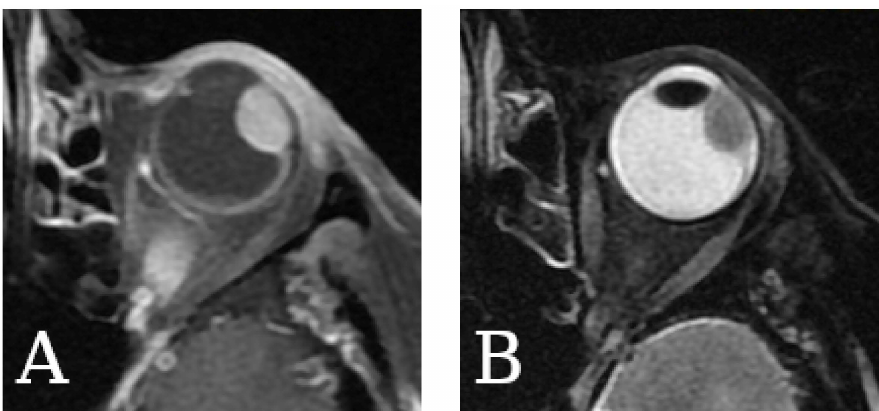
Figure 8. T1- ( A ) and T2-weighted ( B ) MR images of the human eyes with uveal